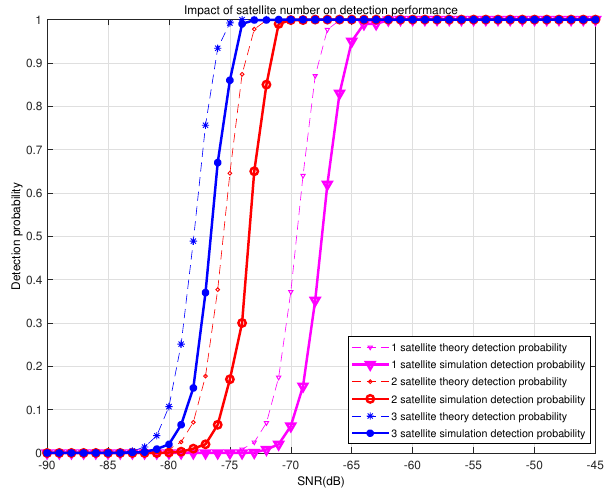
Figure 15. Comparison of detection performance between CCAF and